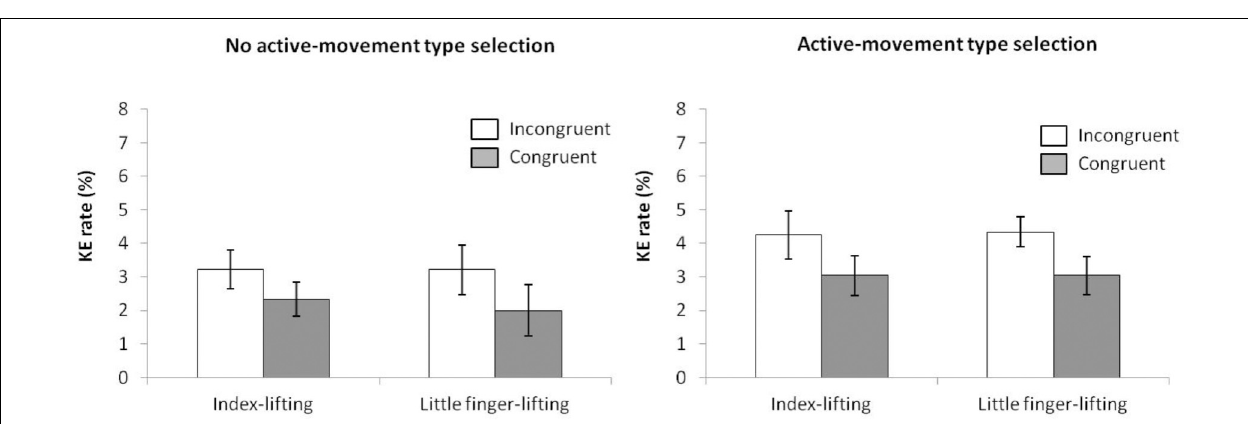
Frontiers in Psychology |